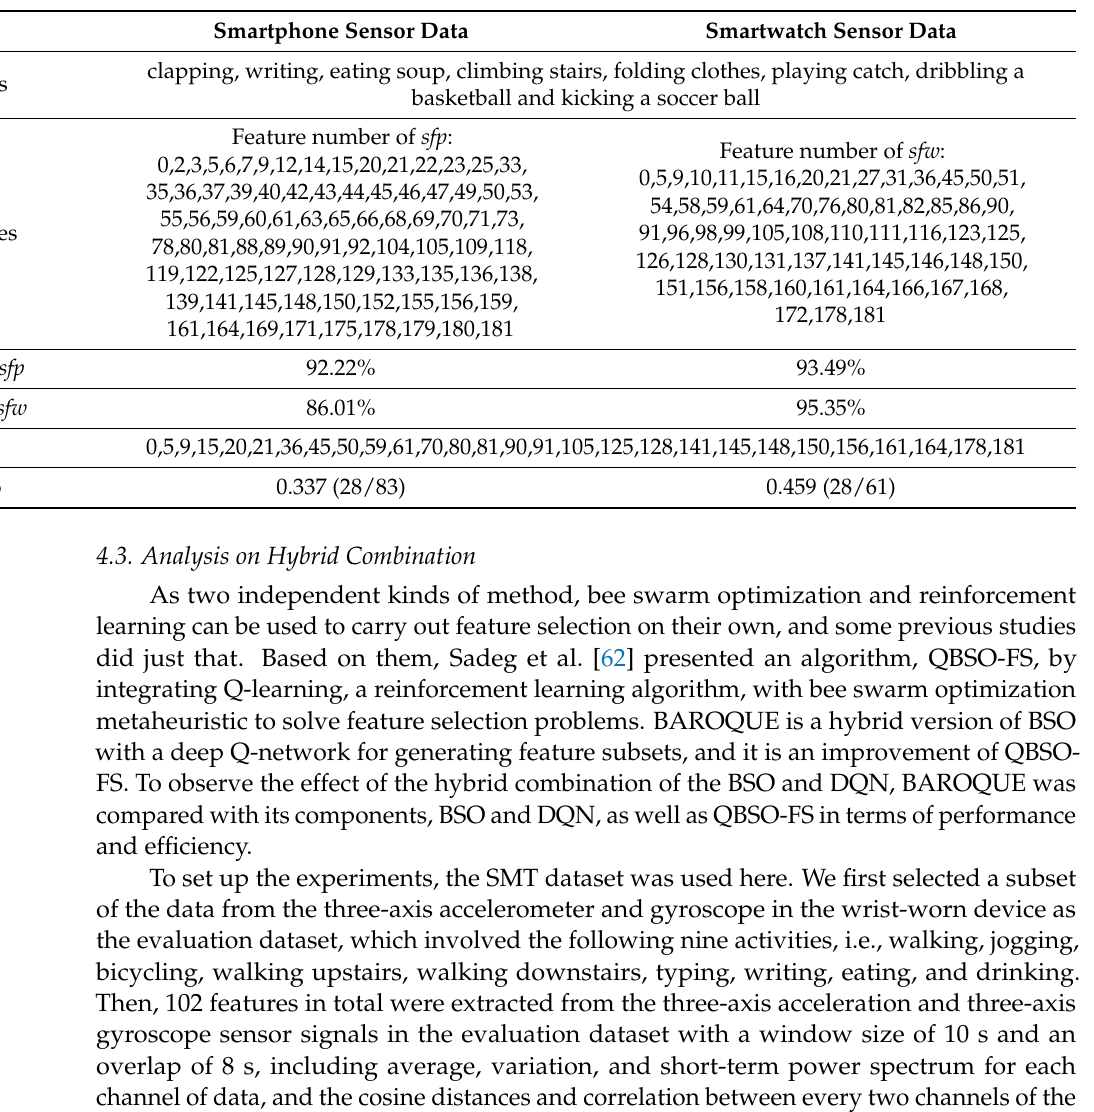
Table 3. Performance of different feature subsets extracted by BAROQUE from the smartphone and smartwatch sensor data in the WISDM dataset,